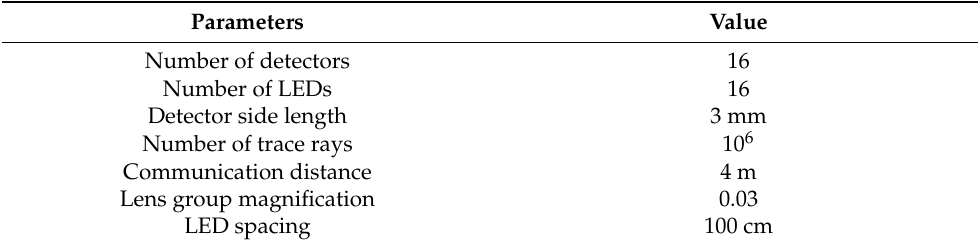
Table 1. ZEMAX optical simulation parameters for Massive MIMO.